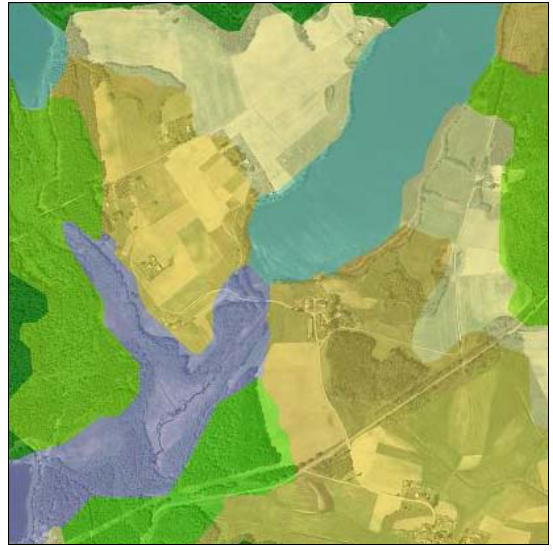
Fig. 5. Land cover structure of the most patchy (22 land cover patches, 9 types) selected sample (belonging to lake terrain landscape type, located in Lazdijai district, No 25). This sample represents a geosystem with average buffer potential *